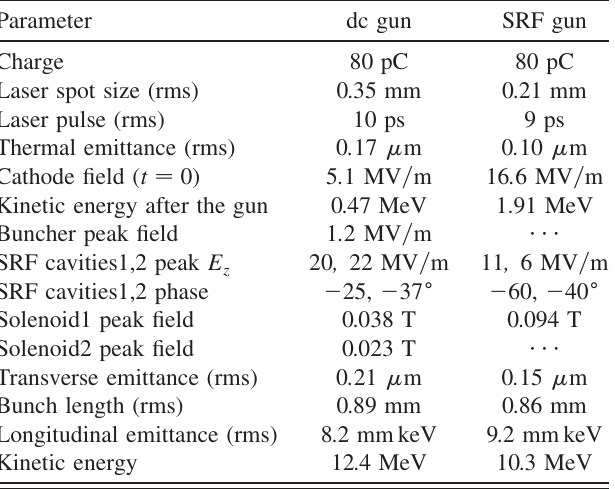
TABLE I. Main injector parameters after optimization.